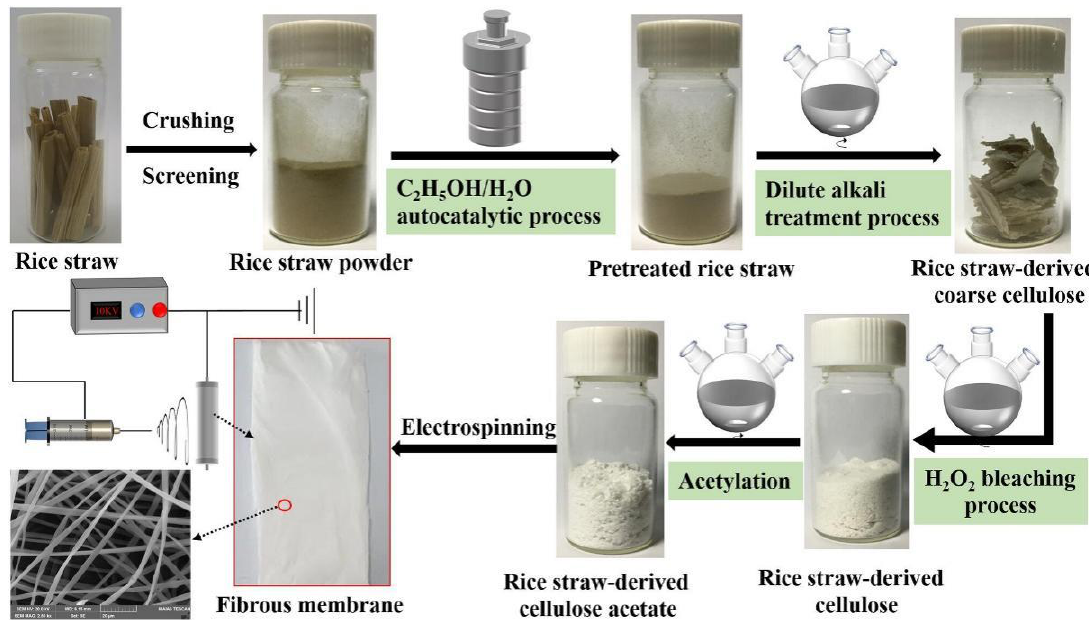
Figure 1. Schematic illustration of the preparation and electrospinning of rice straw-derived cellulose acetate.